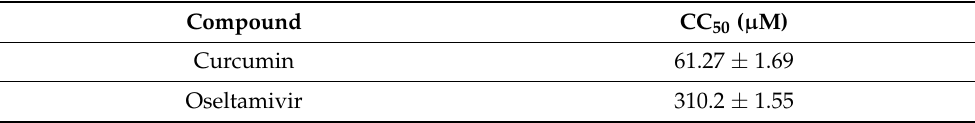
Table 4. Cytotoxic effects of curcumin in MDCK